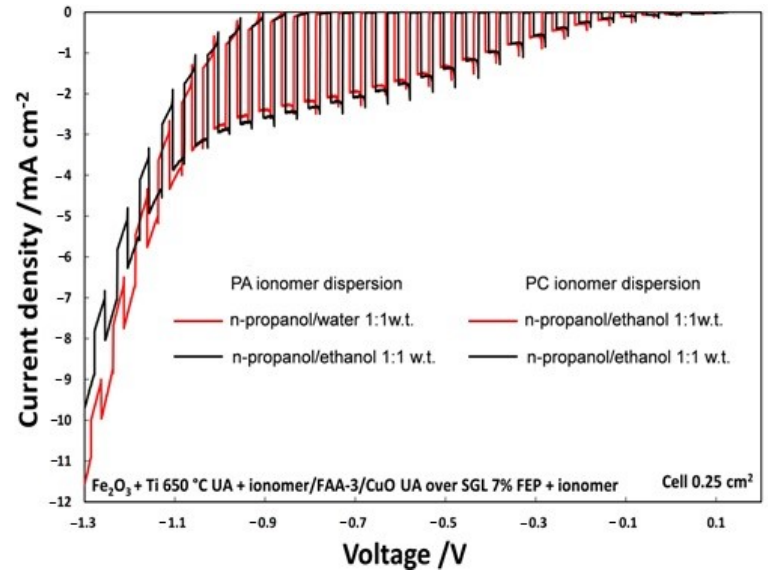
Figure 5. Polarization chopped curves for the two di ff erent ionomer dispersion at photoanode.